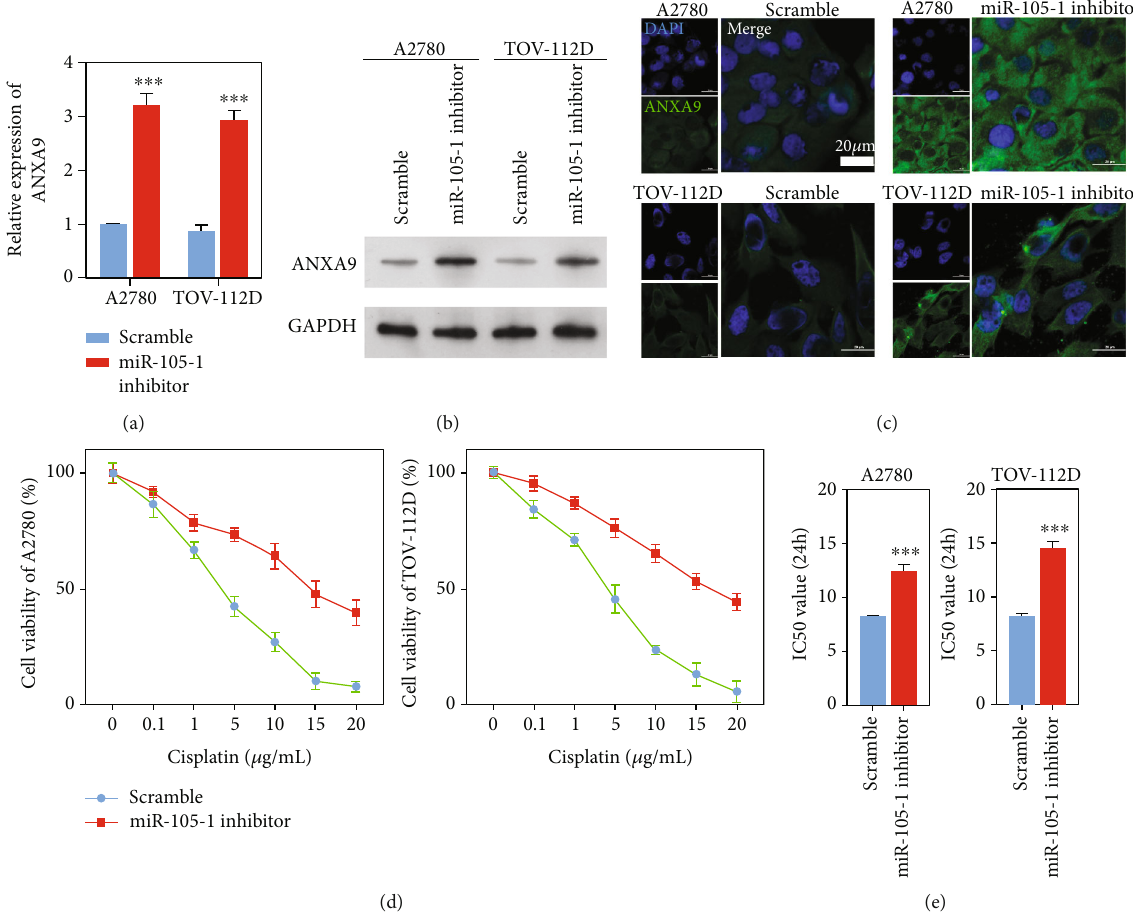
Figure 3: Downregulation of Hsa-miR-105-1 promoted ANXA9 expression. A2780 and TOV-112D cells were transfected with scramble or the Hsa-miR-105-1 inhibitor. (a) The levels of ANXA9 mRNA expression as detected by the QPCR assay ( n = 3 , ∗∗∗ P < 0 : 01 , and paired t -test). (b) The levels of ANXA9 protein expression as detected by the western blotting. (c) The distribution of ANXA9 was shown by immuno fl uorescence. (d) The viability of scramble- or HAS-miR-105-1-treated A2780 or TOV-112D cells after exposure to di ff erent concentrations of cisplatin, as detected by the CCK8 assay. (e) The IC values for A2780 and TOV-112D cells treated with the scramble 50 or Hsa-miR-105-1 inhibitor when exposed to cisplatin ( n = 3 , ∗∗∗ P < 0 : 01 , and paired t